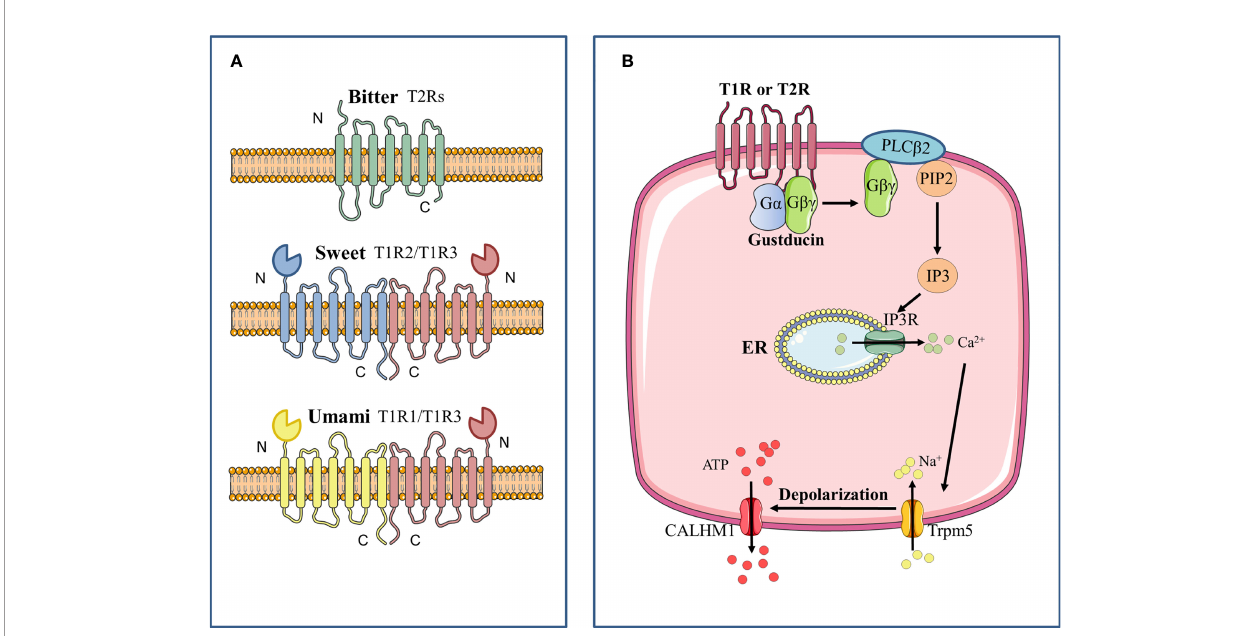
FIGURE 1 | Signal transduction pathway of bitter, sweet, and umami GPCRs. (A) Bitter, sweet and umami receptors are all G-protein coupled-receptors. Bitter receptors are composed of T2Rs, while sweet (T1R2/T1R3) and umami (T1R2/T1R3) receptors are composed of T1Rs, which are characterized by a large N terminal domain that forms a Venus fl ytrap structure. (B) After stimulation of the taste receptor, the downstream G bg complex is mobilized, which then activates phospholipase C isoform b 2 (PLC b 2) to induce the production of inositol 1,4,5-trisphosphate (IP3). IP3 then activates the IP3 receptor (IP3R), an intracellular ion channel that allows the release of Ca 2+ from the endoplasmic reticulum (ER), resulting in an increase in intracellular Ca 2+ . The complex of transient receptor potential cation channel subfamily M member 5 (TRPM5) is then activated and triggers the inward Na + diffusion. The depolarization causes activation of the complex of calcium homeostasis modulator 1 (CALHM1) channels, thus resulting in the release of ATP as the